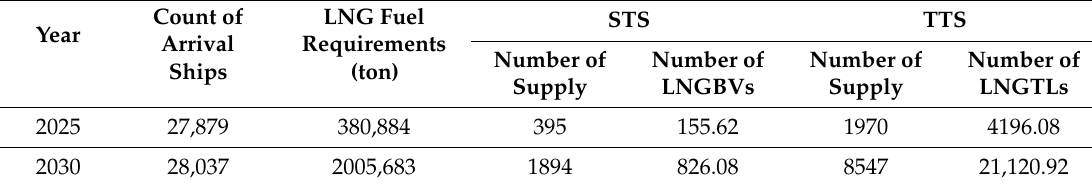
Table 17. Number of Supply and the Number of LNGBVs by